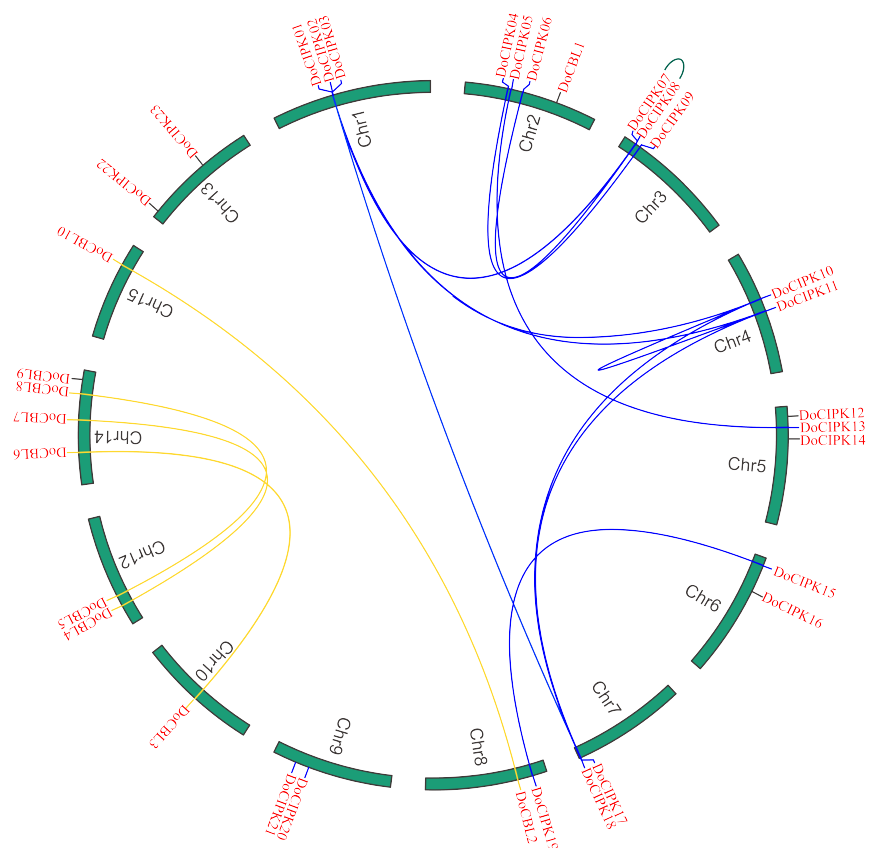
Figure 3. Genome–wide synteny analysis of CBL – CIPK genes in oil persimmon. Gene pairs of DoCBL and DoCIPK genes are linked by blue and yellow lines, respectively. Blue and yellow lines represent segmental duplications, and green arc represents tandem duplications.